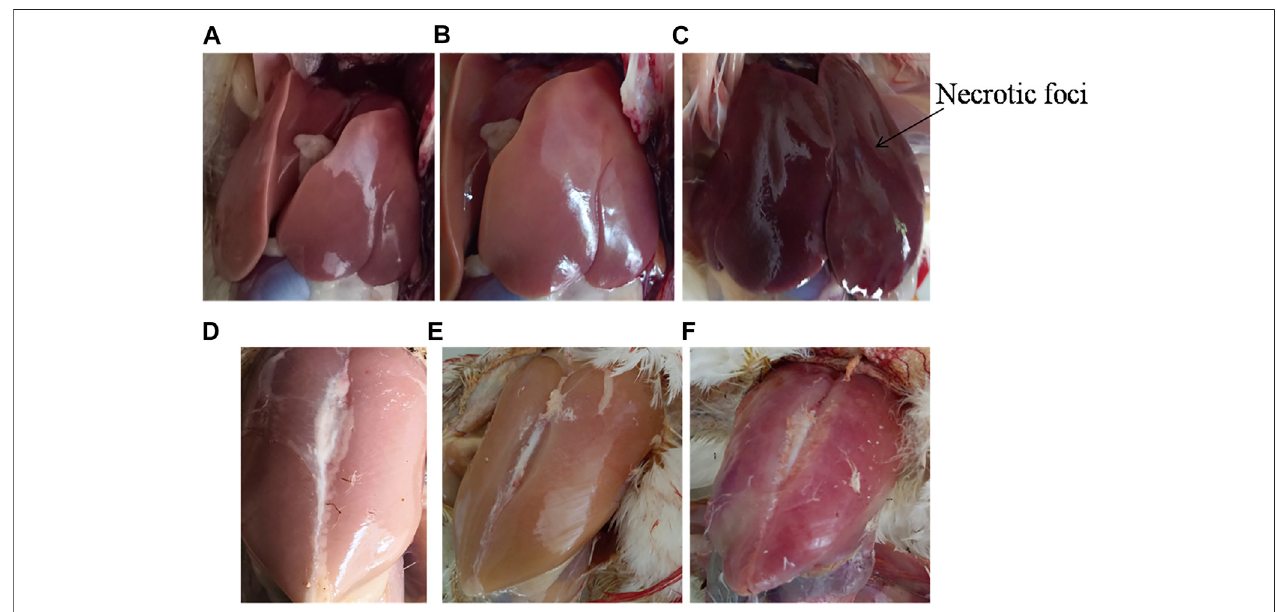
FIGURE 7 | Gross pathology of dead poultry birds exhibiting typical lesions of fowl typhoid. (A) Liver of control and (B) Δ SpvB_SG18 infected birds showing no signs of fowl typhoid. In contrary, (C) the wild type strain (SG18) infected birds showing enlarged livers with necrotic foci, which are typical features of fowl typhoid. Similarly,thegrosspathologyof (D) thecontroland (E) Δ SpvB_SG18-infectedbirdsshowednoapparentlesionofdisease,suggestingthatthesechickenswereclinically healthy, while (F) the SG18-infected birds showed signs of fever and in fl ammation caused by S. gallinarum .